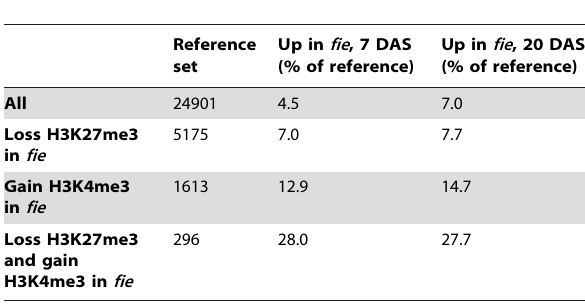
Table 3. The percentage of up-regulated genes in fie mutants is positively correlated with loss of H3K27me3 and gain in